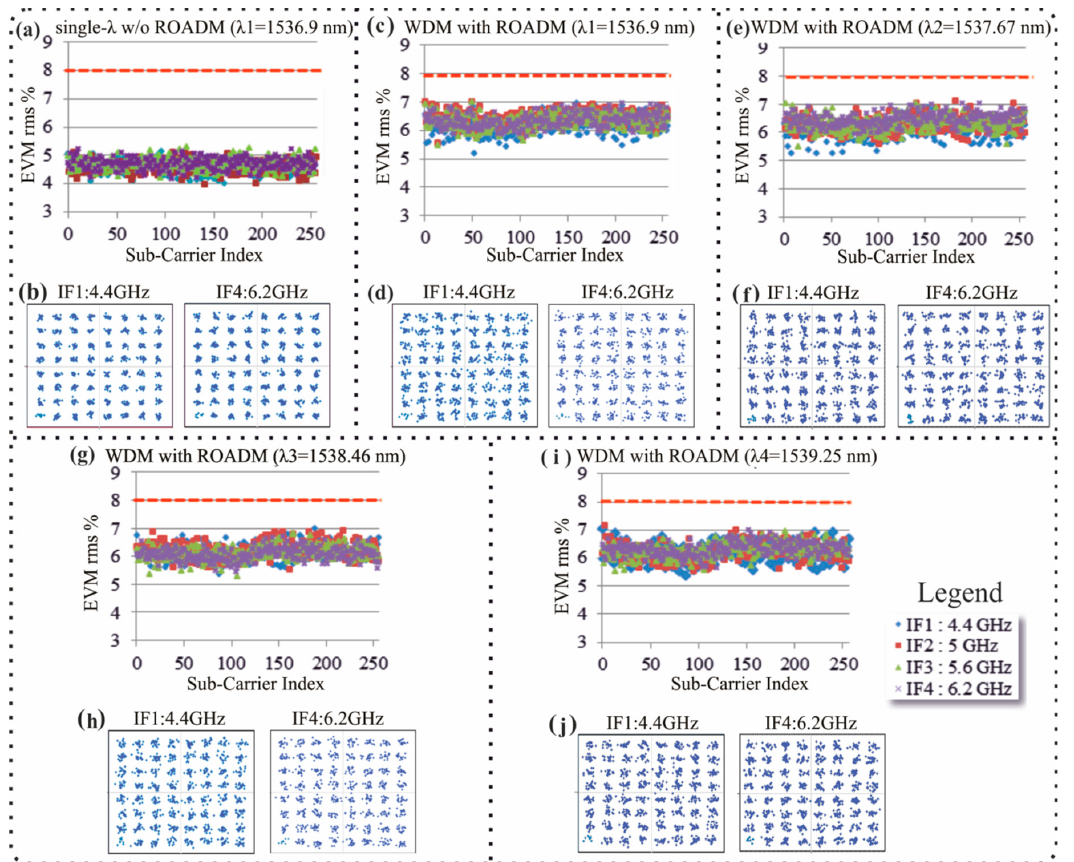
Figure 7. Link w / o ROADM and single λ transmission of OFDM 64-QAM: ( a ) EVM per SC for all IF bands for λ 1 at a ROP of − 13 dBm, ( b ) constellation diagrams of the worst performing SC for the first and last IF band. Hotspot WDM Link with ROADM: ( c ) EVM per SC for all IF bands for WDM1 ( λ 1 = 1536.9 nm) at a minimum ROP of − 13 dBm, ( d ) constellation diagrams of the worst performing SC for the first and last IF band at λ 1 . ( e ) EVM per SC for all IF bands for WDM3 ( λ 3 = 1538.46 nm) at a minimum ROP of − 13 dBm, ( f ) constellation diagrams of the worst performing SC for the first and last IF band at λ 3 .